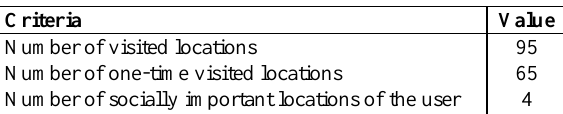
Table 1. Statistical information of the social media